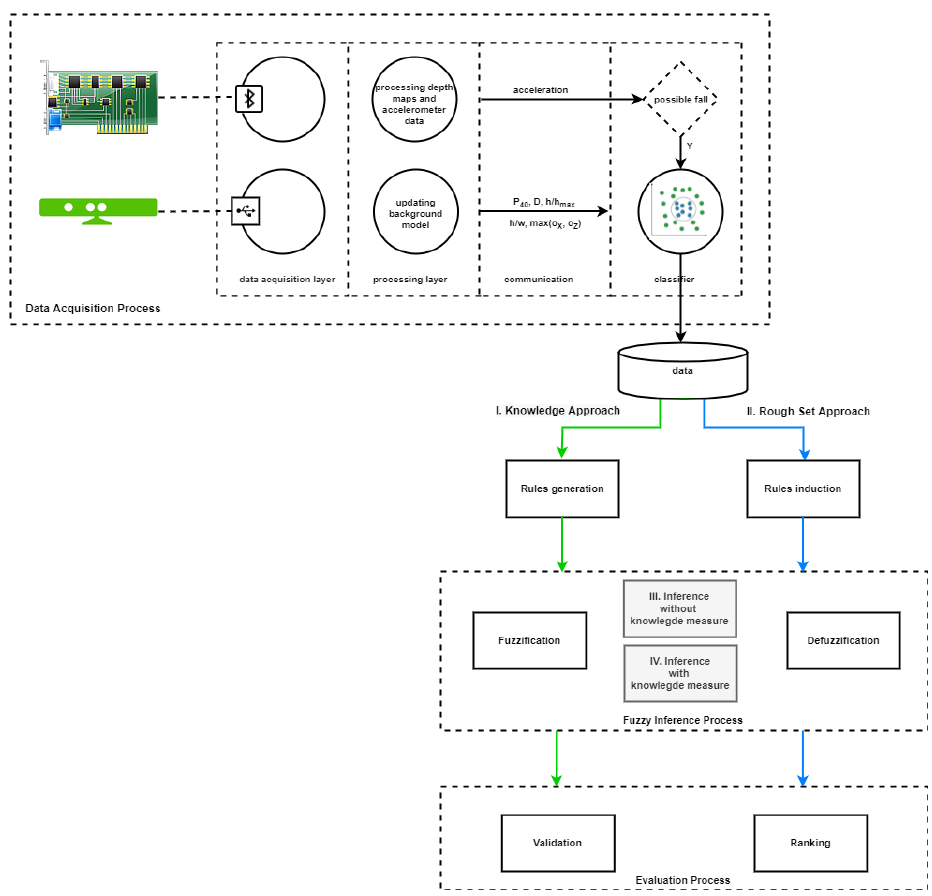
Figure 2. The Scheme of the fuzzy inference